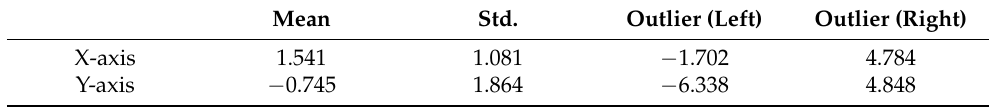
Table 6. Descriptive Statistic for Documents vectors.